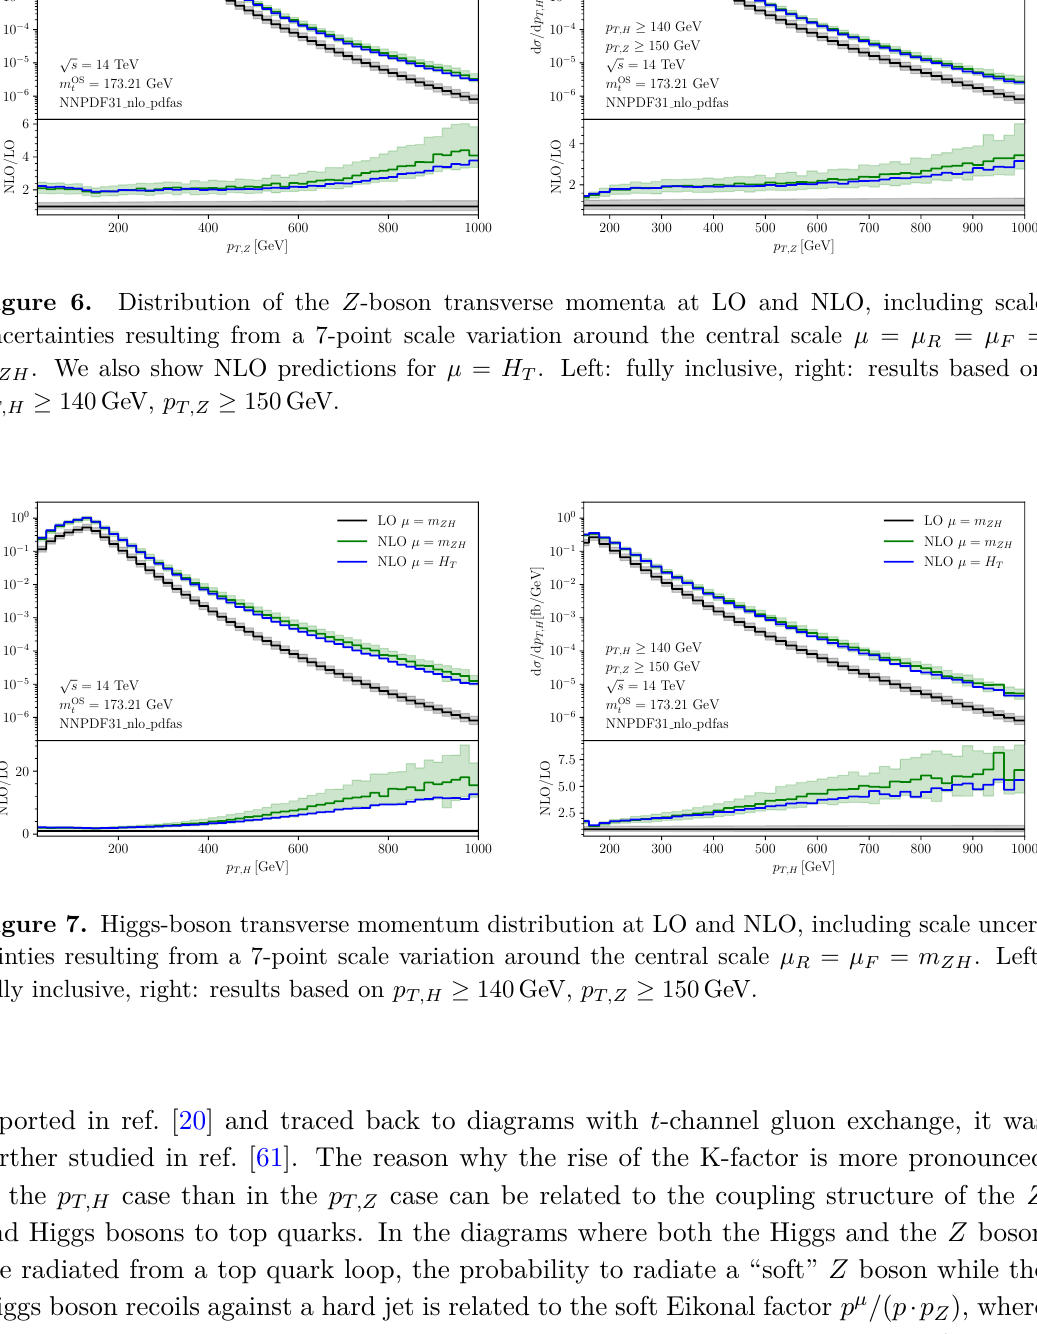
reported in ref. [20] and traced back to diagrams with t -channel gluon exchange, it